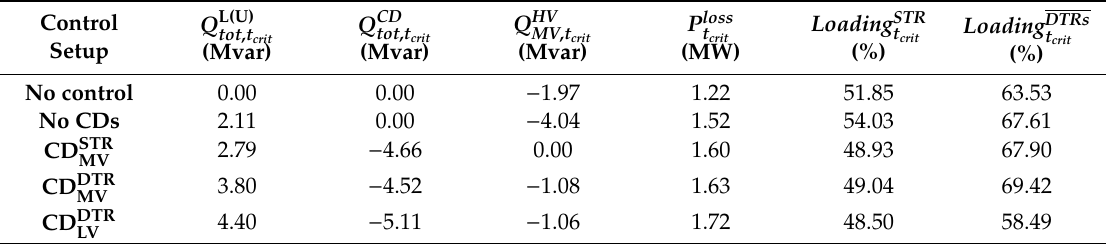
Table 3. Behaviour of the distribution grid with overhead conductors in MV level at t crit for di ff erent control setups.